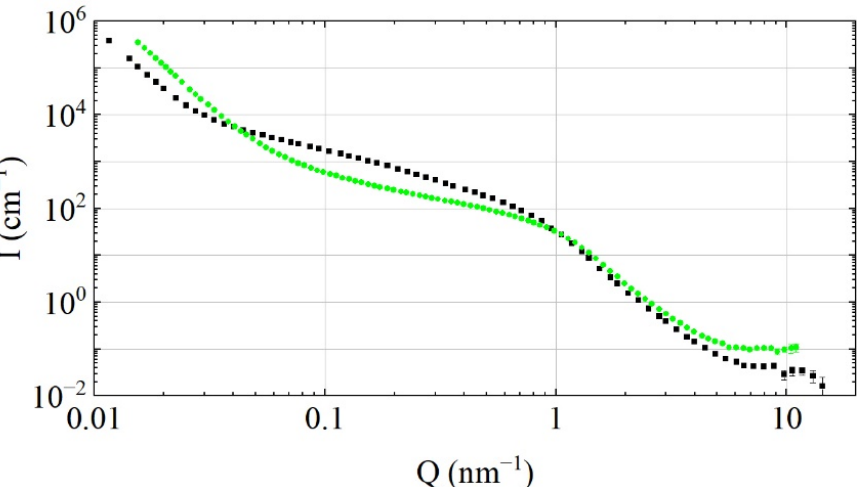
Figure 4. Intensity I (nm − 1 ) of neutron scattering versus transferred momentum Q (nm − 1 ) for DF-DNDs (black squares) and S-DNDs (green circles). To compare only the effect of particle sizes, and not powder density, both curves are normalized to the sample density of 1 g/cm 3 . SANS character- ization was performed with YuMO, D11, and NGB30 instruments, and their neutron wavelengths and ranges of transferred momenta (Q) were equal to 0.7–5.0 Å and 7×10 − 2 nm − 1 < Q < 10 1 nm − 1 ; 6 Å and 10 − 2 nm − 1 < Q < 10 0 nm − 1 ; and 6 Å and 3.4×10 − 2 nm − 1 < Q < 1.2×10 0 nm − 1 , respectively. The Q-ranges used for the summary plot for the S-DNDs are as follows: 1.55×10 − 2 nm − 1 –8.53×10 − 1 nm − 1 from D11